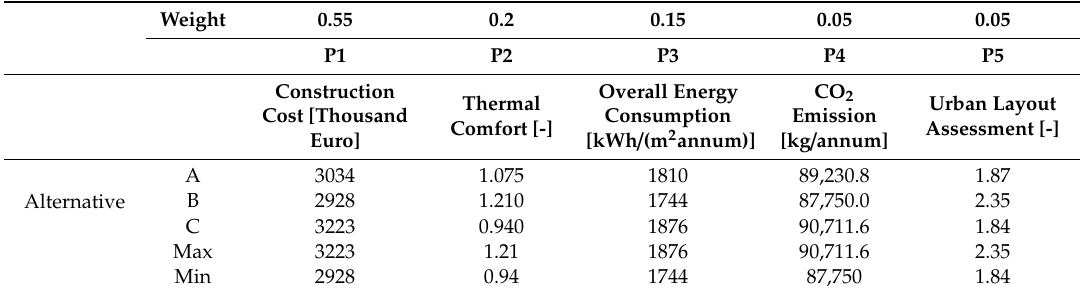
Table 12. The numerical values entered into the WASPAS method for all layouts.